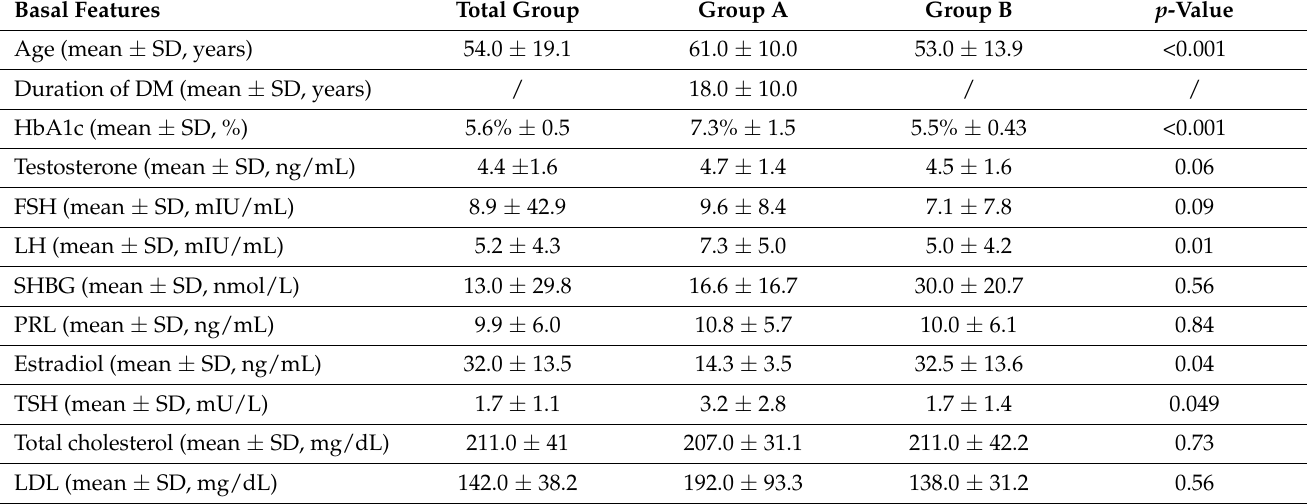
Table 1. Comparison of basal features between patients with DE and DM (Group A) and patients with DE (Group